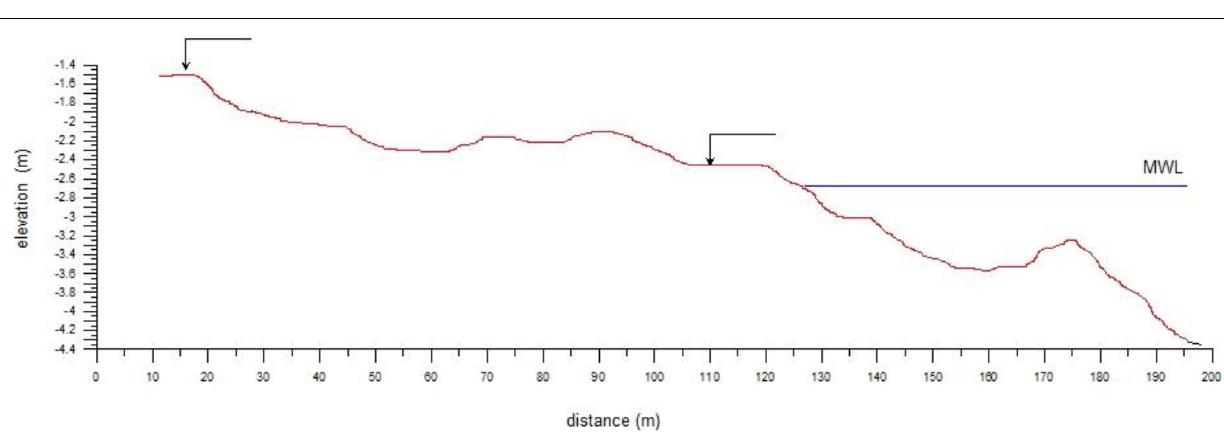
FIGURE 9 | Beach profile (red line) from the Ebro delta in the Spanish Mediterranean coast, referred to the still water level (blue line) and depicting the inner submerged breaker bar (right hand side) together with the various berms (left hand side), whose level is indicated by arrows. This profile geometry, referred to horizontal cross-shore distance ( X axis) and vertical level ( Y axis) corresponds to typical geometries commonly found in microtidal coasts, but presents similar traits for other beach environments, illustrating the difficulty to define the berm level (B variable in text), which depends on the energy level of incoming waves and the time scale of the